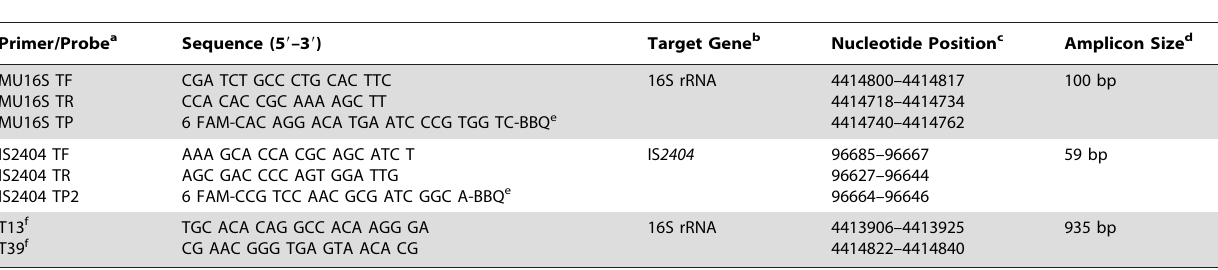
Table 3 indicates primers and probes designed for the 16S rRNA RT-qPCR, the primers described by Fyfe et al., and a re-designed hydrolysis probe used for the amplification, detection, and quantification of IS 2404 [9]. a TF, forward primer; TR, reverse primer; TP2, hydrolysis probe (TibMolBiol, Berlin, Germany). b 16S rRNA, gene for the ribosomal 16S RNA detected as 16S cDNA; IS 2404 , insertion sequence 2404 . c Nucleotide positions are provided for the first (IS 2404 ) or single (16S rRNA) copy of the respective amplicon in M. ulcerans Agy99 (GenBank accession no. CP000325.1) as determined by BLASTN analysis within GenBank (NCBI) [13]. d bp, base pairs. e 6 FAM, 6-Carboxyfluorescein fluorescent dye; BBQ, BlackBerry Quencher. f Primers T13 (forward) and T39 (reverse) were used for the amplification of a 935-bp region of the M. ulcerans 16S rRNA gene, encompassing the region amplified by qPCR primers MU16S TF and MU16S TR, to generate single copy replicates. Furthermore, these primers were used for sequencing of the M. ulcerans 16S rRNA gene (Table 1).